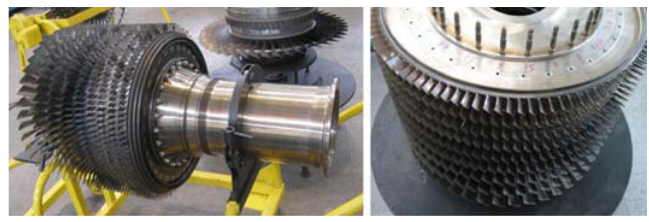
Figure 5. Photograph of the dismountable disk-drum aero-engine rotor.